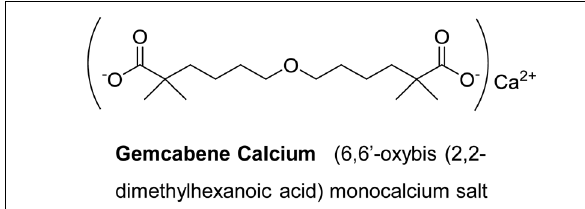
FIGURE 1 | Structure of test